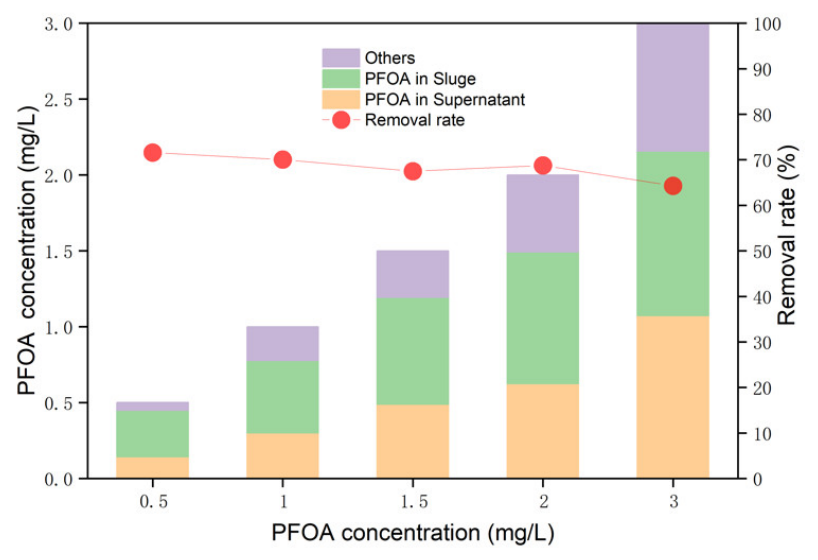
Table 2. The proportion and content of PFOA in supernatant and sludge in each reactor.